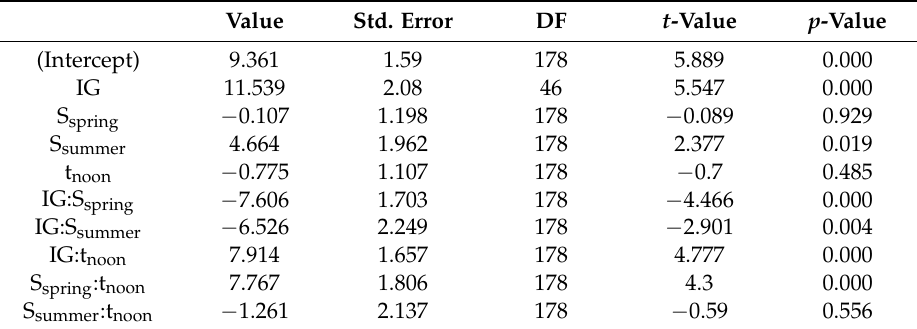
Table A3. Summary of interaction analyzes MVPA